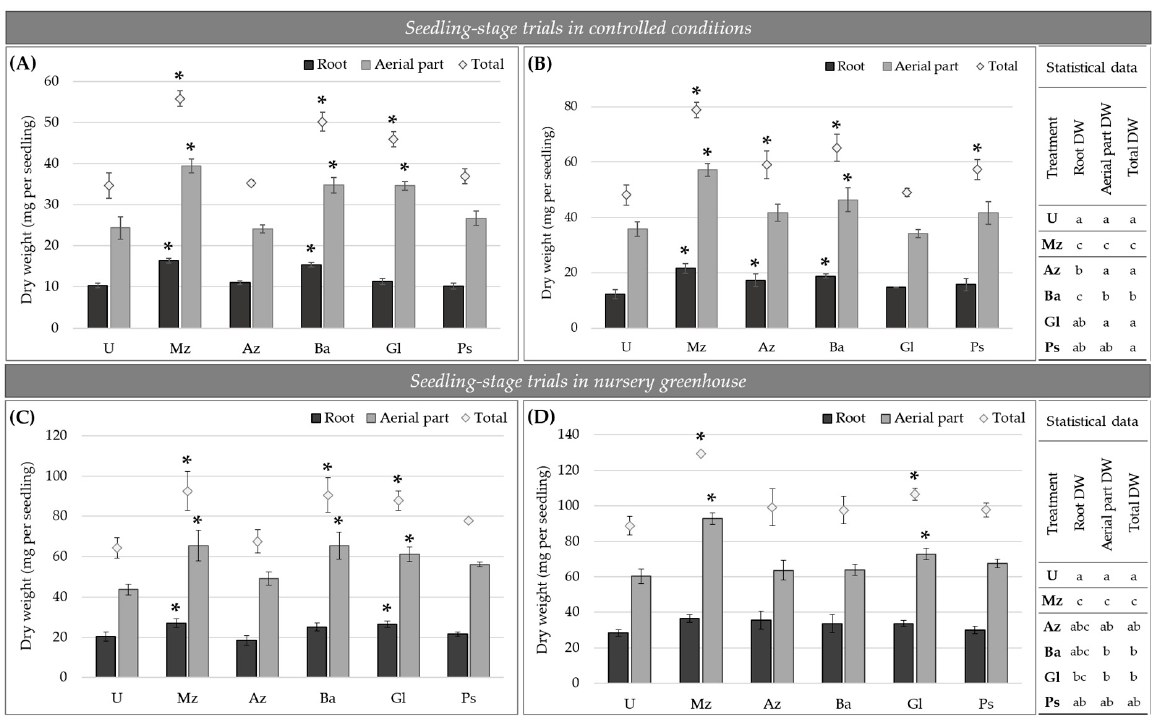
Figure 6. Root, aerial part, and total dry-weight (DW) biomass of lettuce seedlings grown in controlled conditions (( A , B ), independent assays) and in nursery greenhouse (( C , D ), independent assays) 30 days post-inoculation (DPI). In the figure, means of root DW (dark-gray bar), aerial part DW (light-gray bar), and total DW biomass (light-gray diamonds) (and standard deviation of data) of seedlings 30 DPI are plotted. Asterisks above the bar indicate significant differences with respect to the U treatment in each individual trial, at p ≤ 0.05 according to Tukey’s test. Different letters in the statistical data (on the right) indicate significant differences ( p ≤ 0.05) according to Tukey’s test. Mz: multispecies; Az: A. argentinense Az39; Ba: Bacillus sp. Dm-B10; Gl: G. diazotrophicus PAL5; Ps: P. protegens Pf5; U: uninoculated.